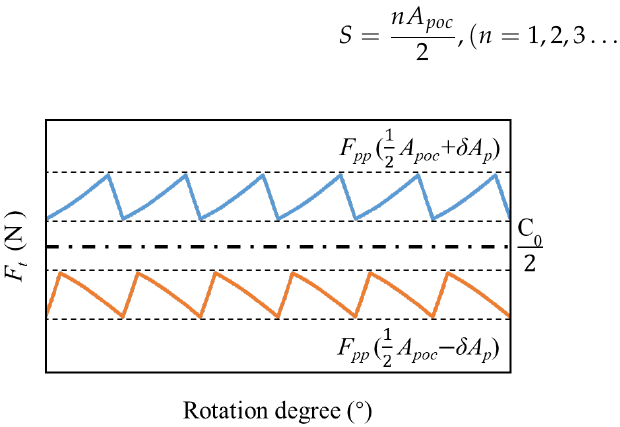
Figure 6. The symmetry characteristics of force fluctuation.